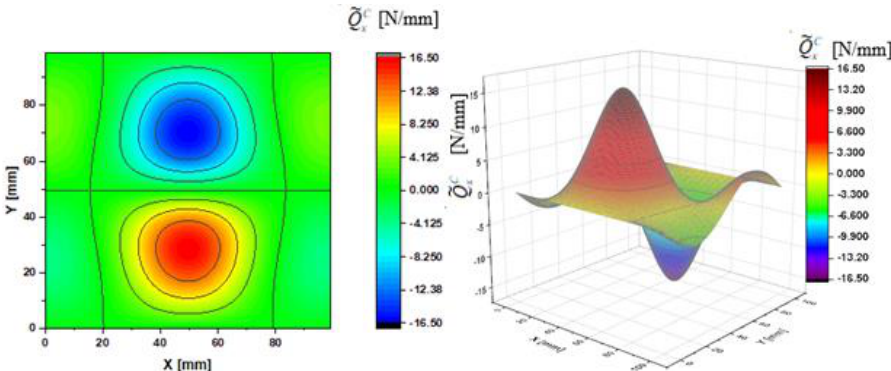
C Q ~ for Case A. Figure 7. Contour-plane chart of (cid:101) Q y for Case A. Q ~ for Case A. y Q ~ for Case A. y y